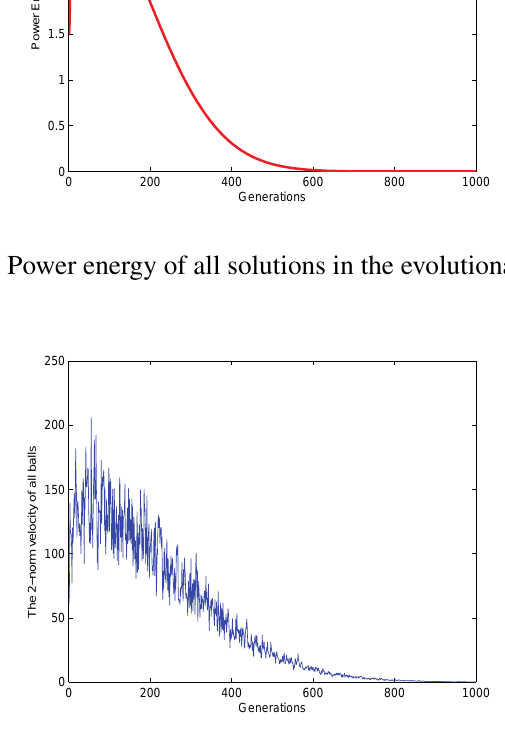
Figure 6: The 2-norm velocity of all solutions in the evolutionary